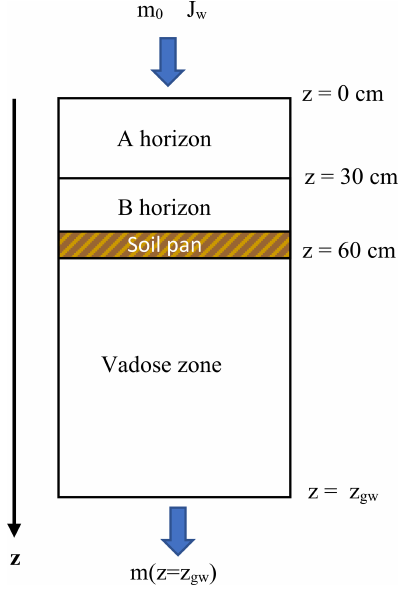
Figure 2. Conceptual model for pesticide leaching from the soil surface to